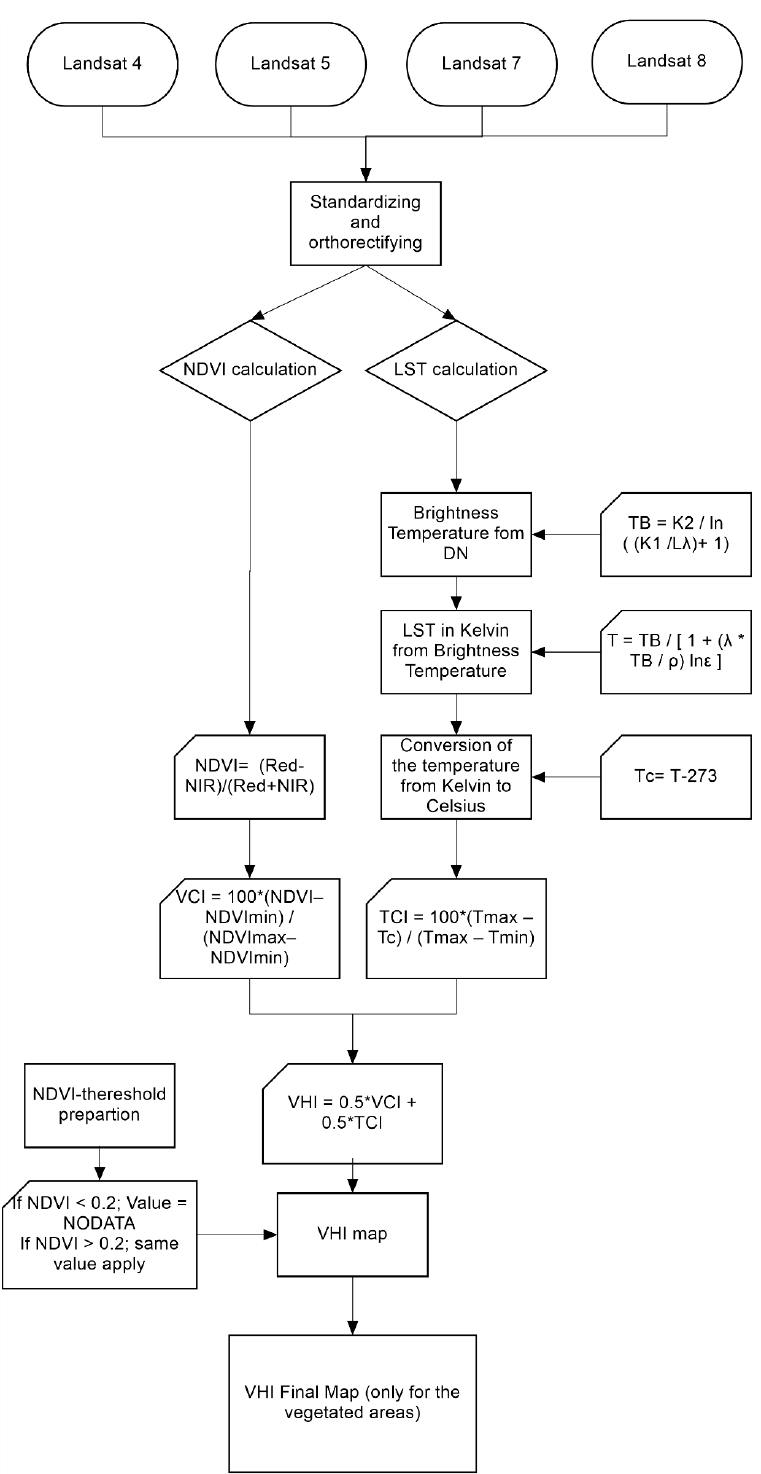
Figure 2. Methodology flowchart for the VHI